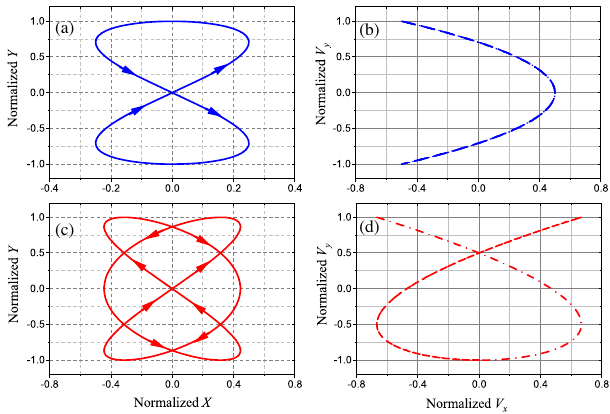
FIG. 2. The electron orbits (solid left) and velocities (dotted right) in the x - y plane, in which the upper subfigures (blue) and lower subfigures (red) are corresponding to the Figure 8 undu- lator and the linear mode of APPLE-Knot undulators, respec-